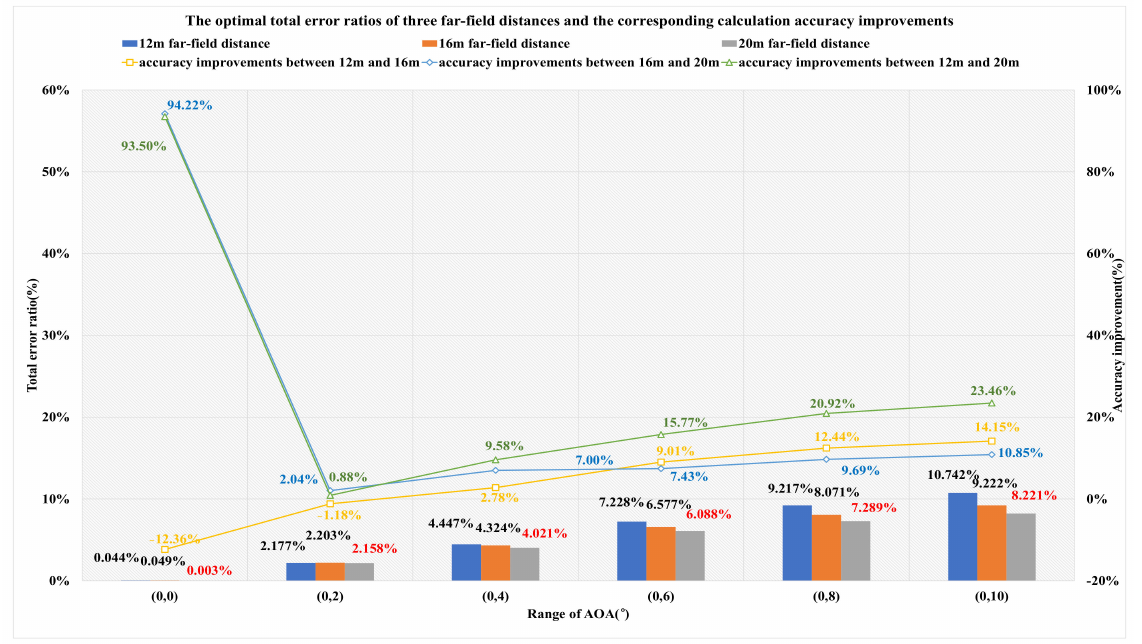
Figure 19. The optimal results of three far-field distances and the corresponding calculation accuracy